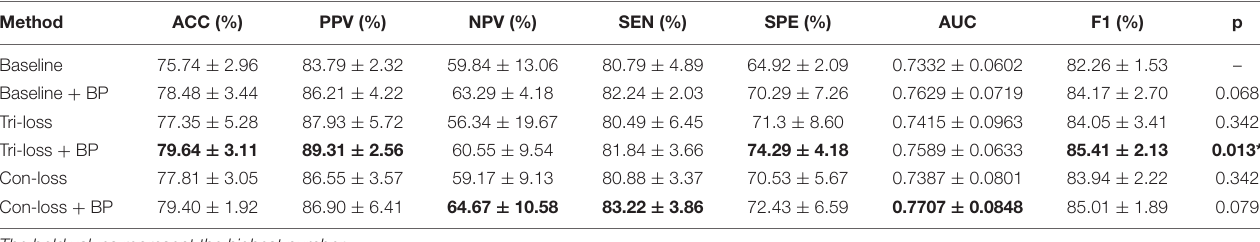
TABLE 2 | Results of the ablation studies of BP module and metric learning losses for EMCI vs. LMCI classification (Mean ± Standard Deviation).